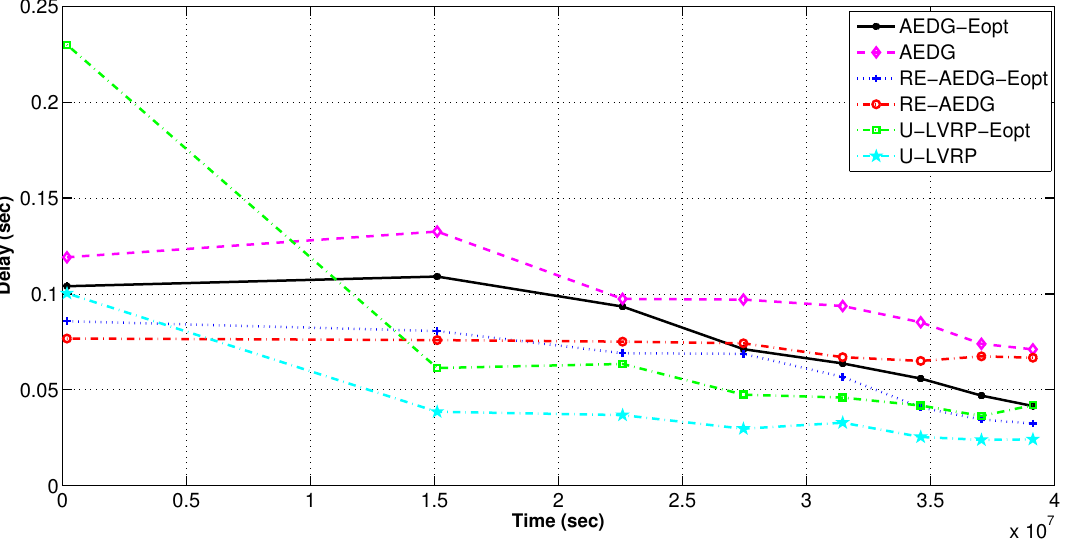
Figure 16. E2E delay in energy optimized and non optimized